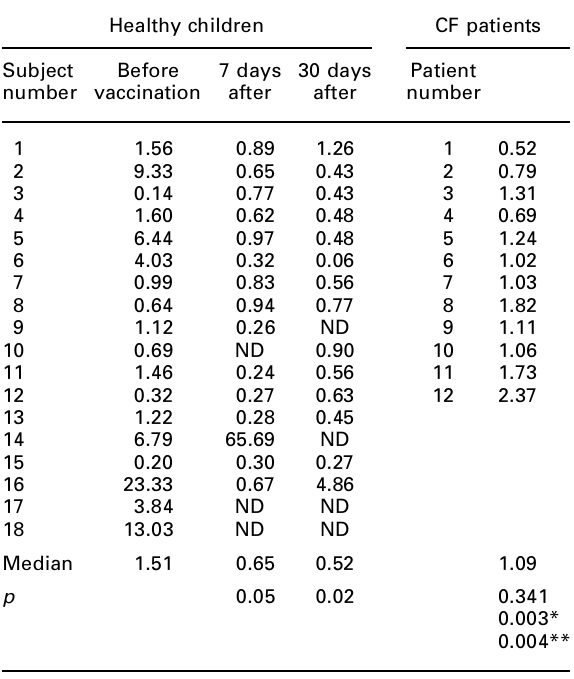
The individual parameters of CF patients are the median values of the results during 6 months of observation. *Compared with the parameters of healthy children 1 week after rubella vaccination. **Compared with healthy subjects on day 30 after inoculation.